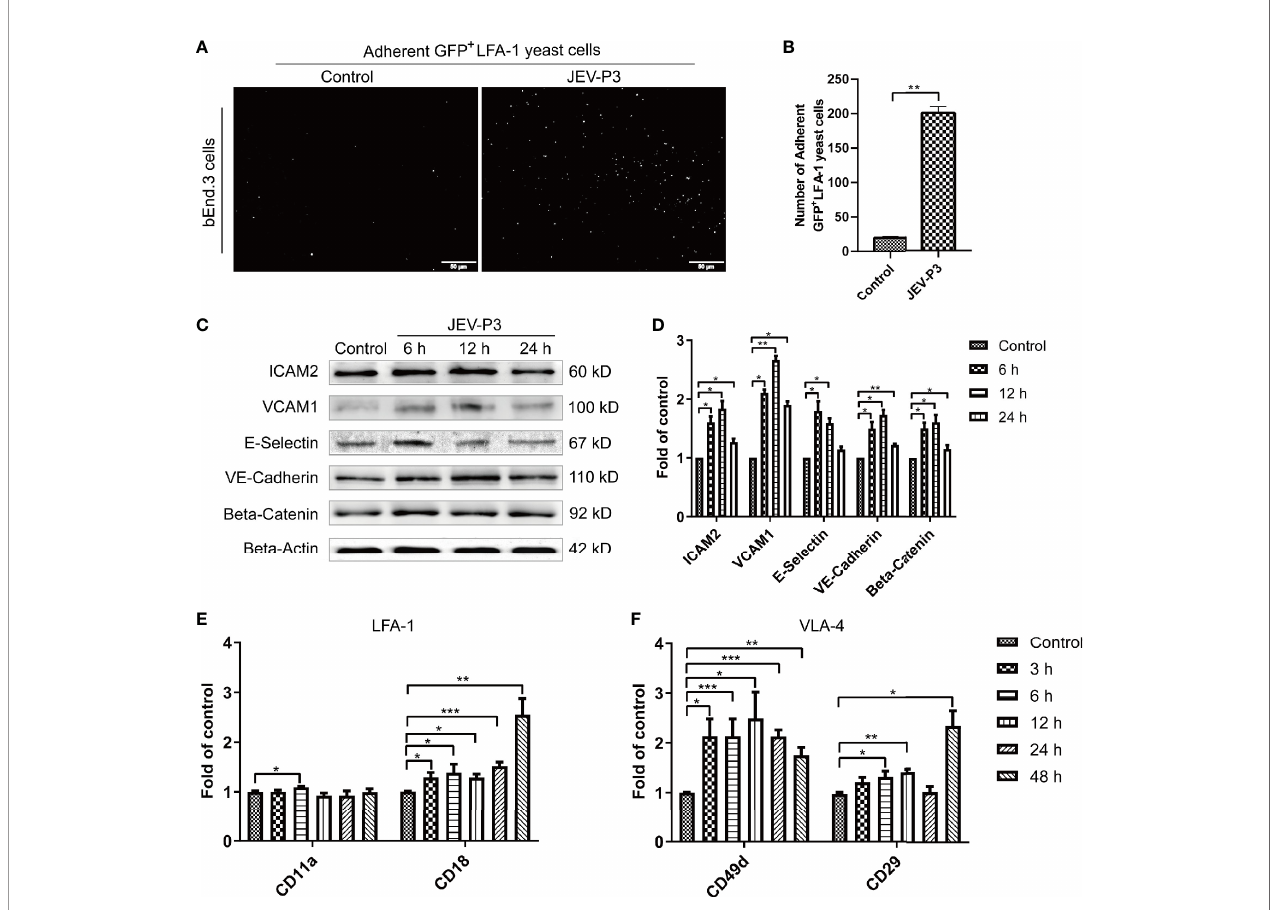
FIGURE 2 | JEV infection upregulated adhesion molecules expression in bEnd.3 cells, and rHMGB1 increased the expression of integrin ligands in splenocytes. (A) ICAM-1 expression level was detected in the JEV-infected bEnd.3 cells at 6 h. Representative images showing the binding of highly expressed GFP+ LFA-1 yeast cells. (B) Statistical analysis of fl uorescence was performed, and the result represents the expression levels of ICAM-1 in bEnd.3 cells. (C) Detection of ICAM-2, VCAM-1, E-selectin (CD62E), VE-cadherin, and beta-catenin expression levels in JEV-infected bEnd.3 cells were determined by Western blotting. Protein samples were collected at 0 h (Control), 6 h, 12 h, and 24 h. (D) The protein expressions reported in panel (C) were normalized to that of beta-actin and quantitatively analyzed as the fold change relative to the control. The expression levels of LFA-1 (CD11a and CD18) (E) and VLA-4 (CD49d and CD29) (F) in rHMGB1-treated (100 ng/ml) mouse splenocytes, determined by real-time PCR at 0 h (Control), 3 h, 6 h, 12 h, 24 h, 48 h. Untreated cells were served as control. The scale bar for (A) is 50 mm. The experiments were repeated at least three times. The data are expressed as the means ± SEM. *p < 0.05, **p < 0.01, and ***p <